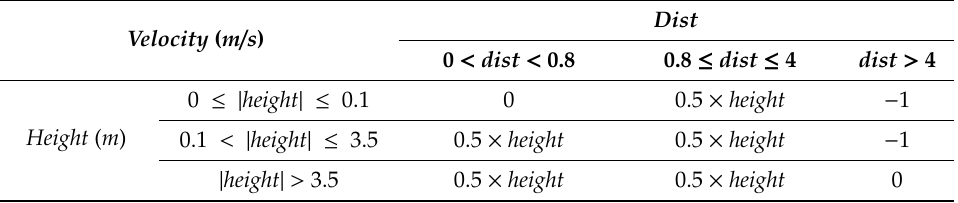
Table 2. The vertical speed generated by heuristic rules.